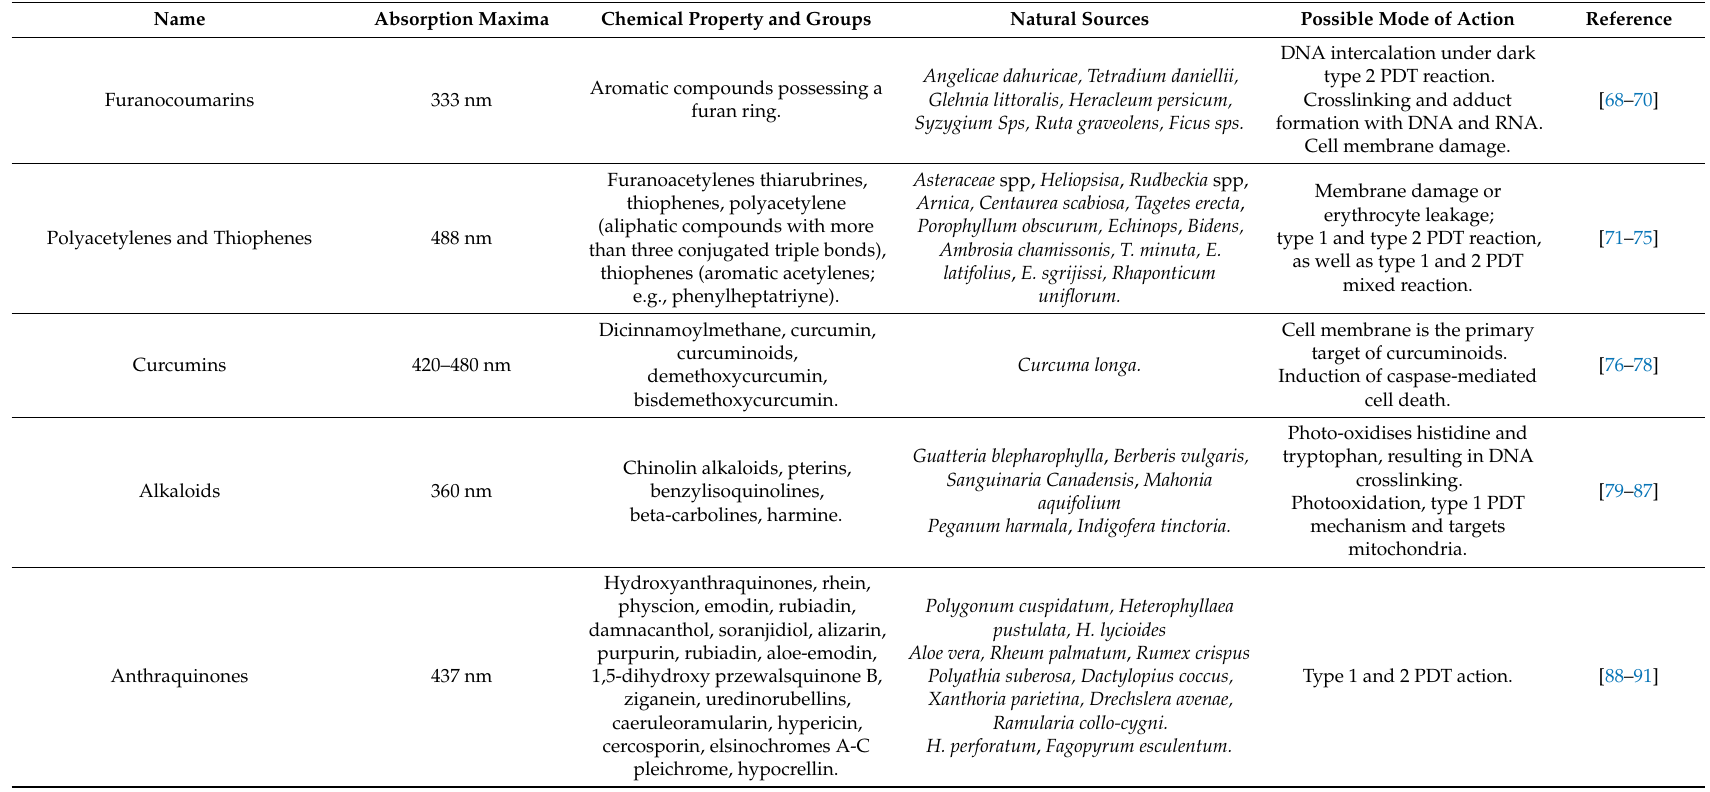
Table 2. List of plant-based natural photoactive compounds with known